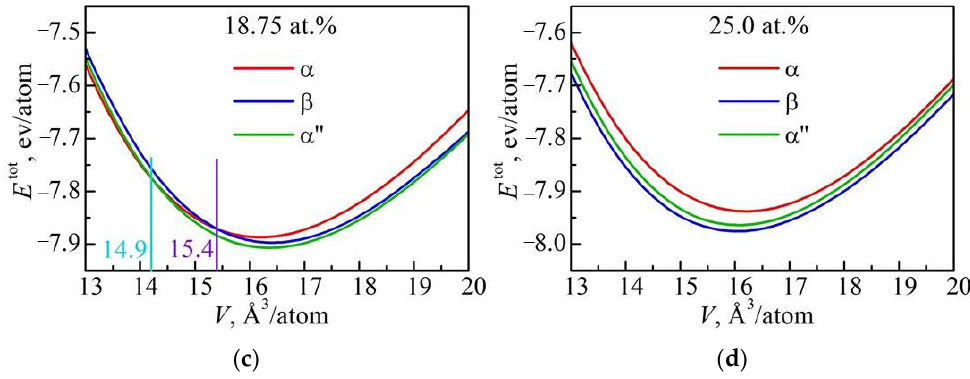
Figure 11. Total energy vs. atomic volume for the α, β and α’’ phases of titanium containing 6.25 ( a ), 12.5 ( b ), 18.75 ( c ) and 25.0 at.% ( d ) of vanadium.